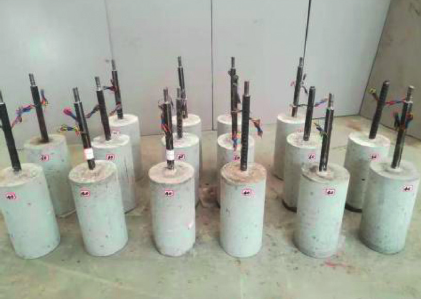
Figure 3: Concrete country rock specimens.